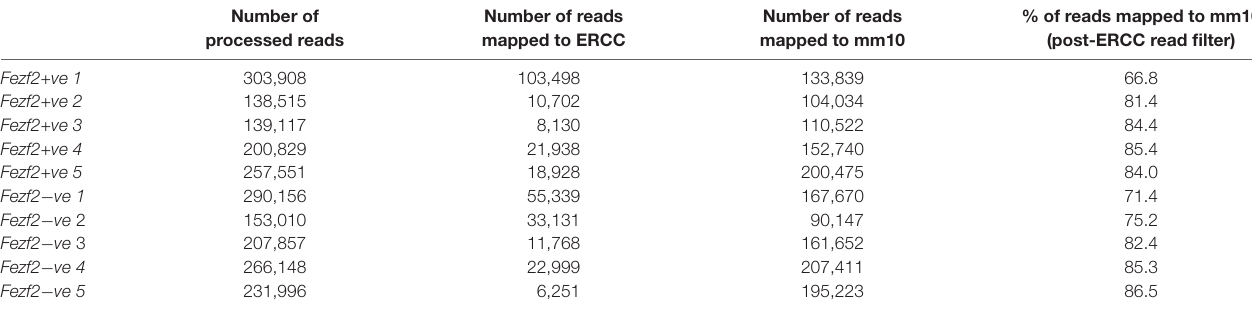
Number of reads mapped to ERCC